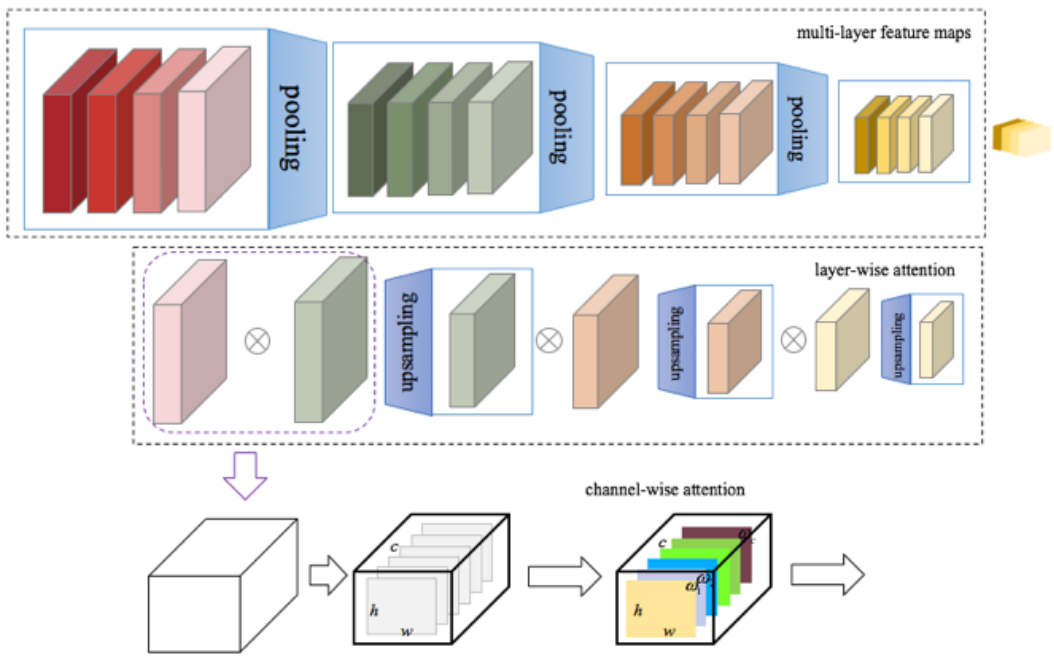
Figure 8. Attention-based network structure. Four layers at different levels have been selected from ResNet-101 for feature fusion; these layers are denoted by C 2 − 5 throughout the remainder of this